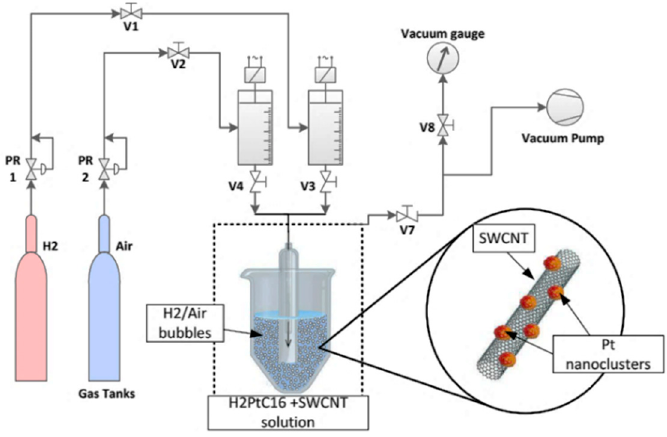
Figure 15. Schematic view of bubling experimental set-up for CNT decoration with Pt nanoclusters [40].